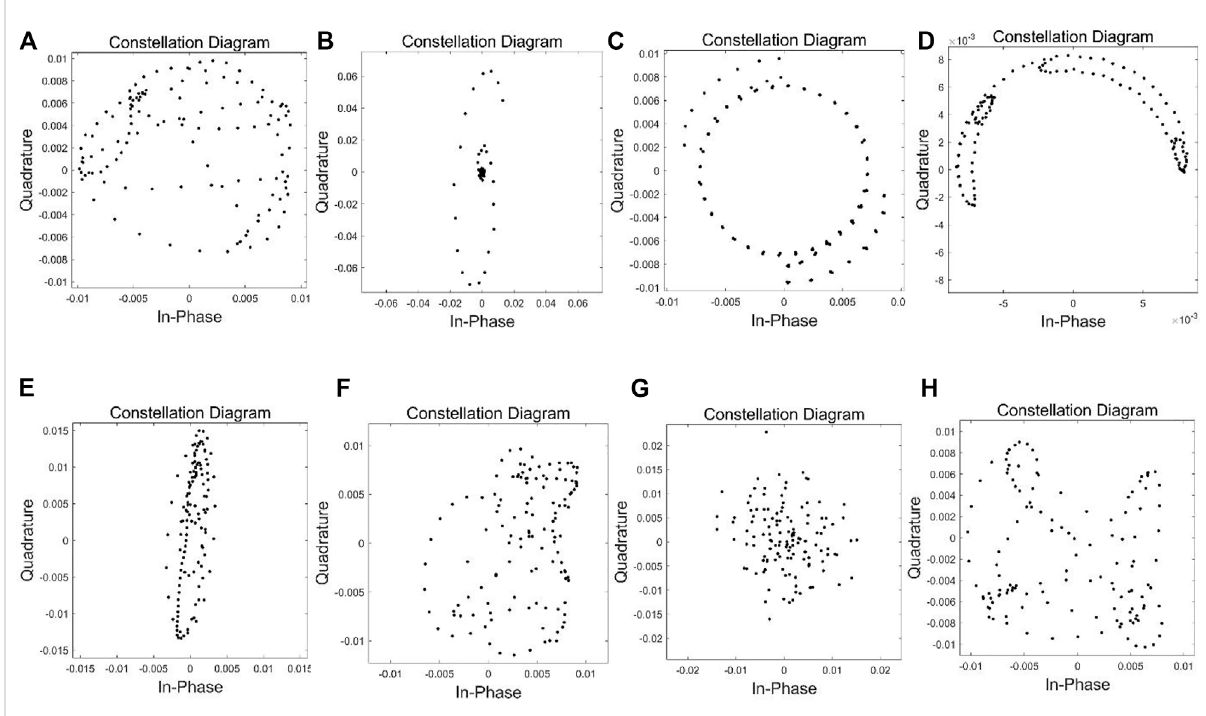
FIGURE 2 Constellationdiagrams ofmodulatedsignalsatSNR=18 dBinRadioML 2016.10Adataset. (A) 8PSK, (B) BPSK, (C) CPFSK, (D) GFSK, (E) PAM4, (F) QAM16, (G) QAM64, (H)